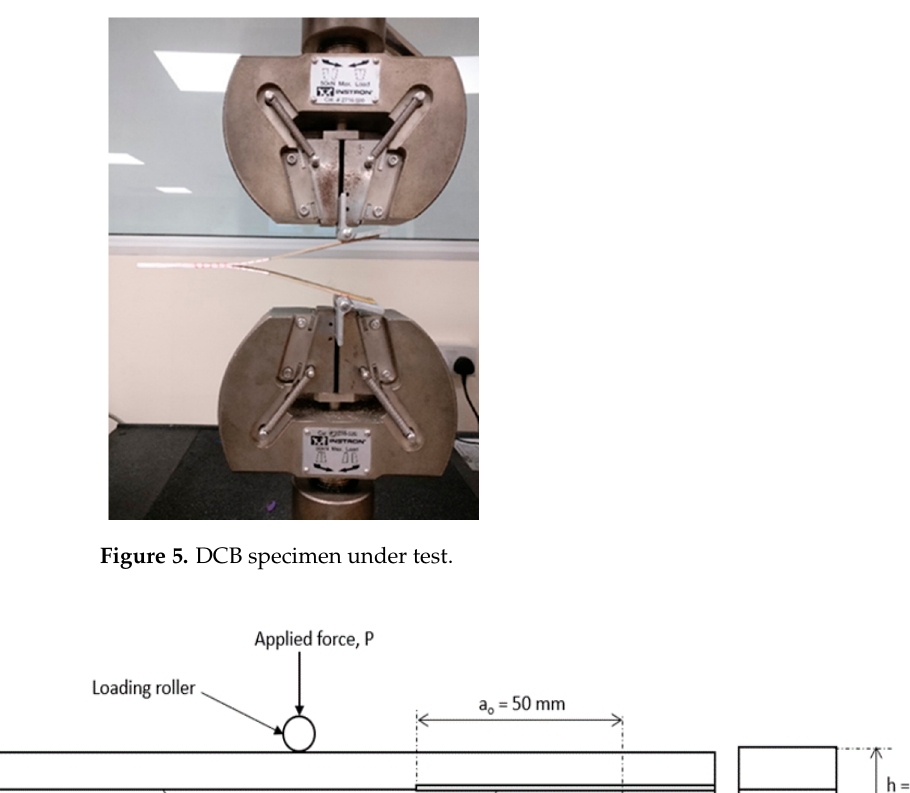
Figure 5. DCB specimen under test.